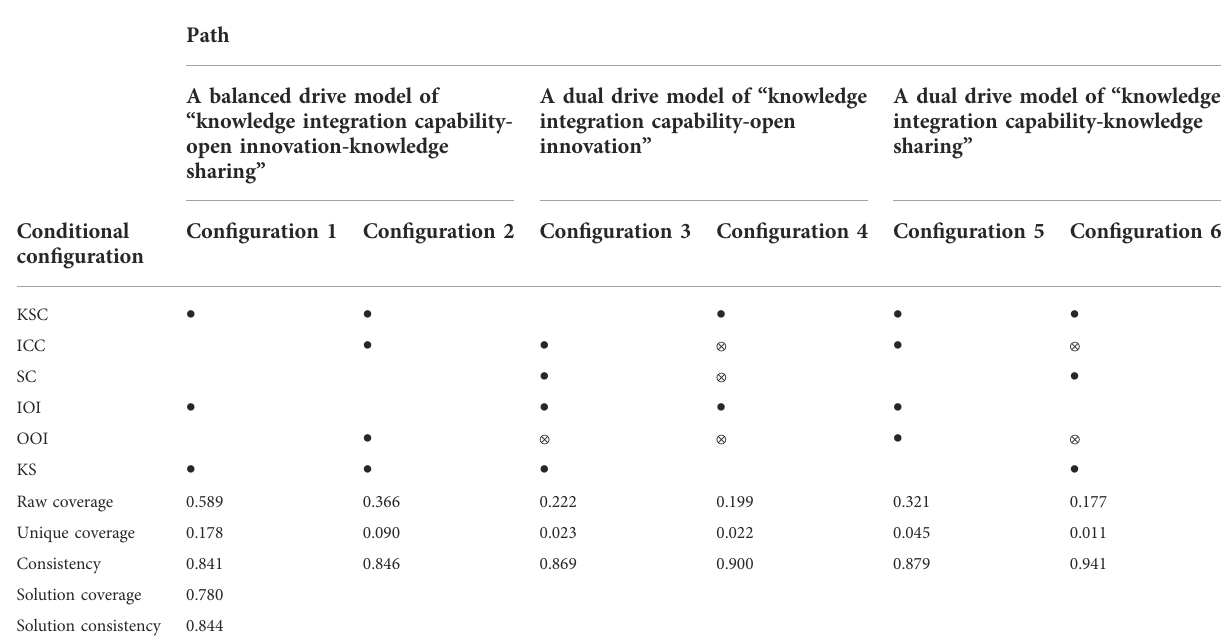
TABLE 4 Suf fi ciency analysis of conditional con fi guration. Path A balanced drive model of “ knowledge integration